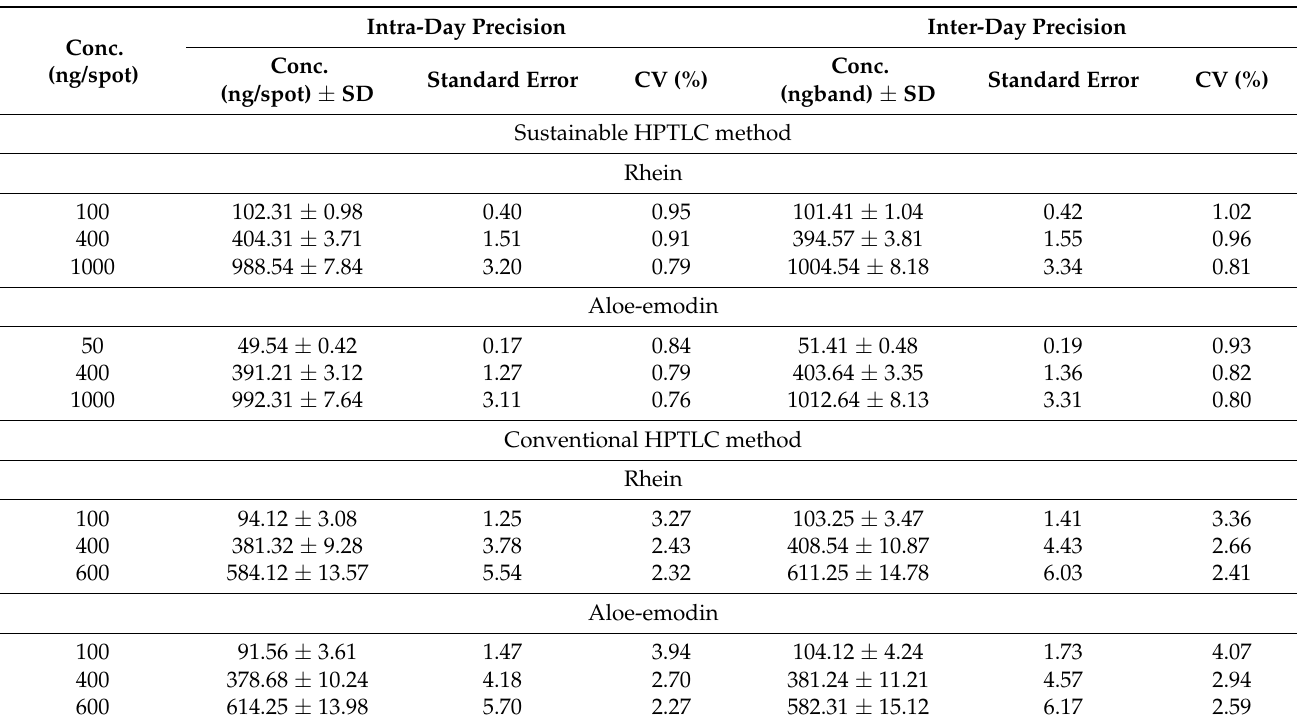
Table 4. Intra/inter-day precision data of rhein and aloe-emodin for the sustainable and conventional analytical assays (mean ± SD; n =